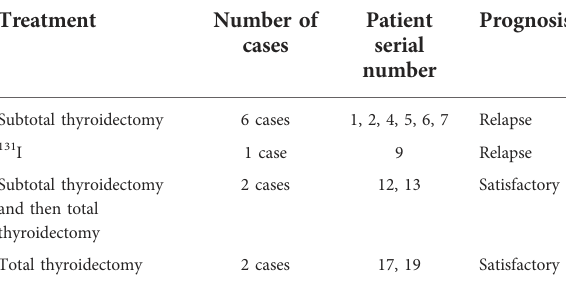
TABLE 2 Surgical and 131 I interventions of thyroid in MAS